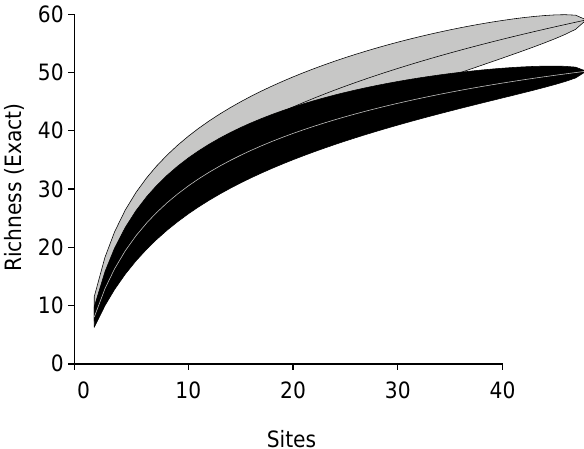
Figure 2. Rarefaction curves of soil meso- and macrofauna in response to litter from plant species tested (black curve - Schinus terebinthifolius ; gray curve - Senna multijuga ).